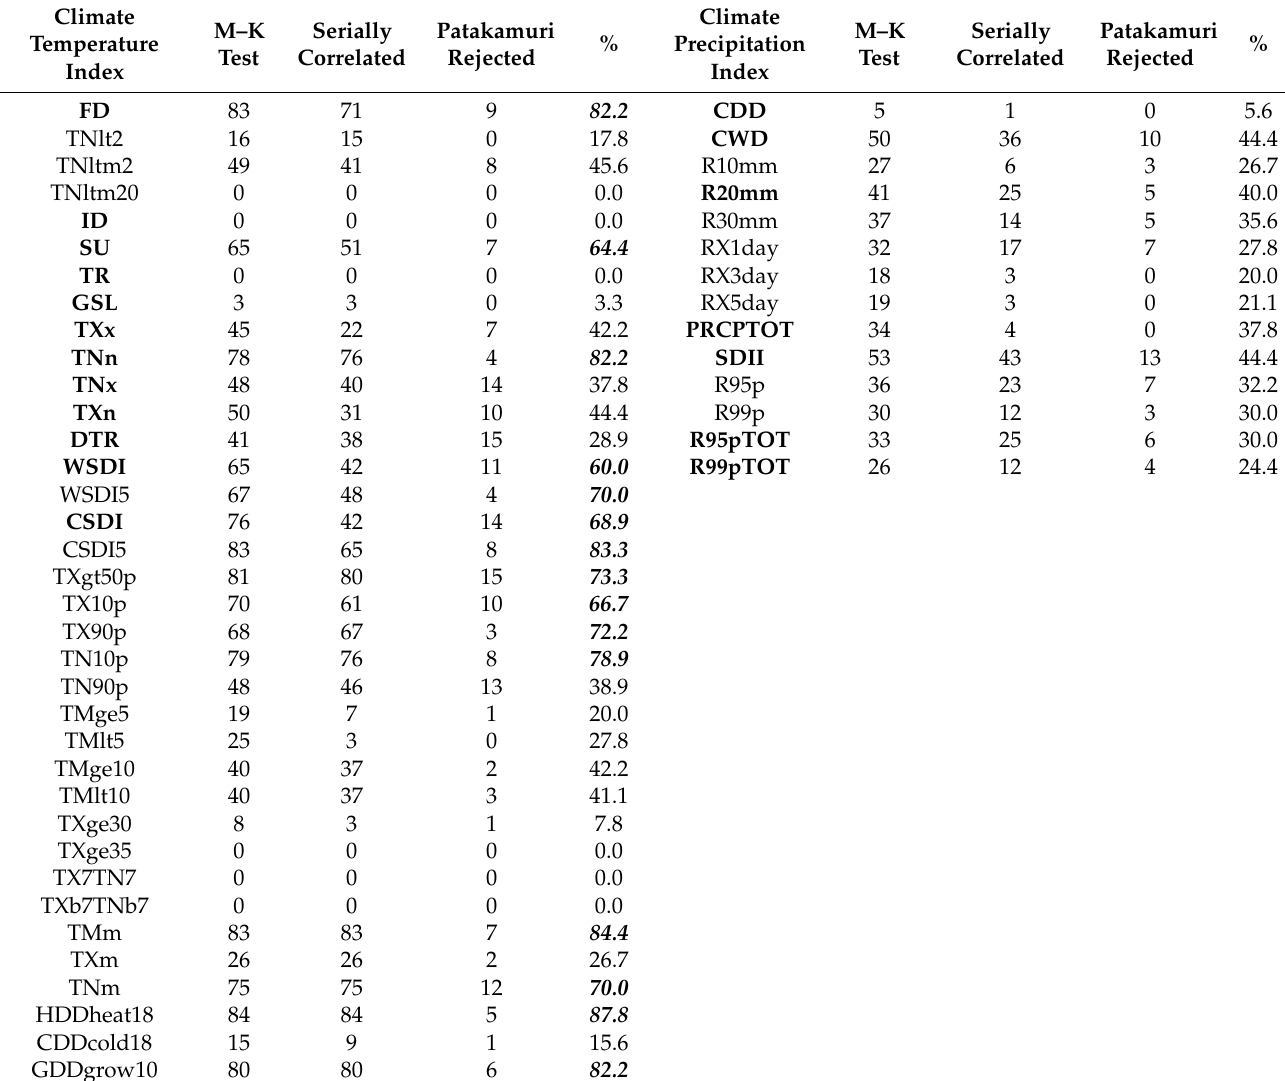
Table 5. Statistics of the 50 CCI with the number of stations (out of 90) whose time series: (i) passed the M–K test for trend detection, (ii) were serially correlated, (iii) were rejected by the Patakamuri tests, and (iv) percentage of stations whose trend was statistically significant. The bold letters in the column of the climatic indices correspond to the ETCCDI indices, and the bold italics in the % column are those where at least 50% of the total were statistically